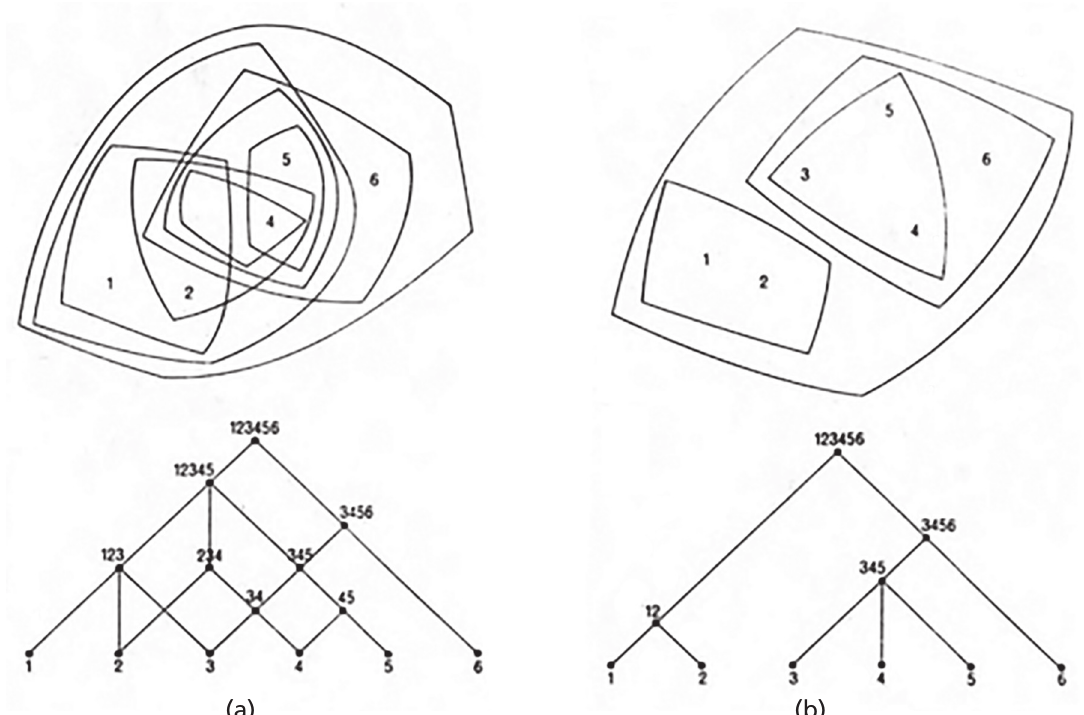
Figure 1. Semilattice ( a ) and Tree Structures ( b ). Source: { A City is Not a Tree }